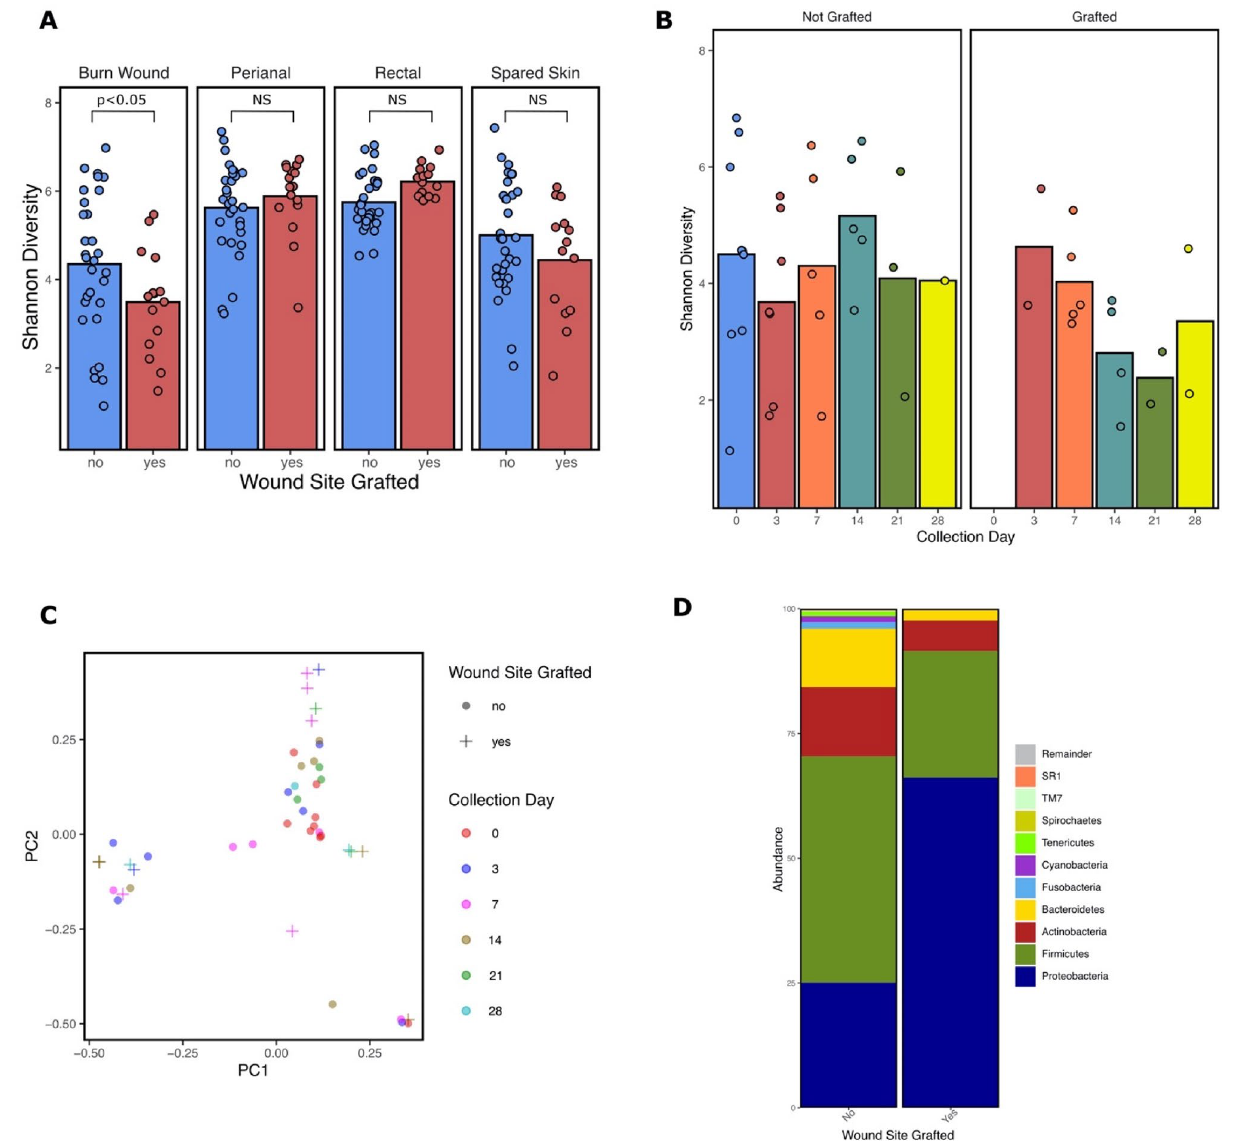
Figure 6. Effects of grafting on burn wound alpha diversity and taxonomy. ( A ) Mean Shannon Diversity from each sampling location (burn wound, spared skin, perianal, and rectal) clustered by presence or absence of grafting at the wound sampling location. Diversity at the burn wound is significantly reduced when grafted. ( B ) Mean Shannon Diversity from the burn wound samples over time clustered by wound grafting status. ( C ) PCOA plot of Bray Curtis dissimilarity of the burn wound samples displaying grafting status and collection day. The first and second principal components (PC1 and PC2) are shown, explaining 14.8% and 13.31% of the variance, respectively. Samples cluster significantly by PERMANOVA by grafting status ( P = 0.002). ( D ) Taxonomic summary of the top 10 phyla sequenced at the burn wound and clustered by wound grafting status. NS , not significant. This figure was generated using the software Inkscape and visualizations generated by